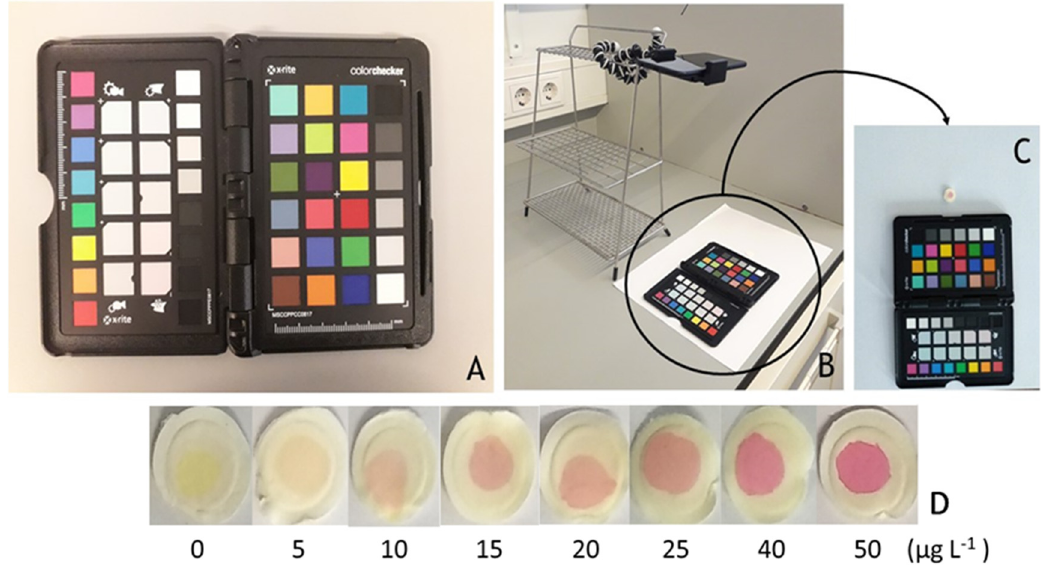
Figure 1. Experimental apparatus for image acquisition ( A ). Color chart; ( B , C ). Representation of the placement of the disk beside the color chart; ( D ). Disks after loading of SMZ (0–50 µg L − 1 ) and color development.